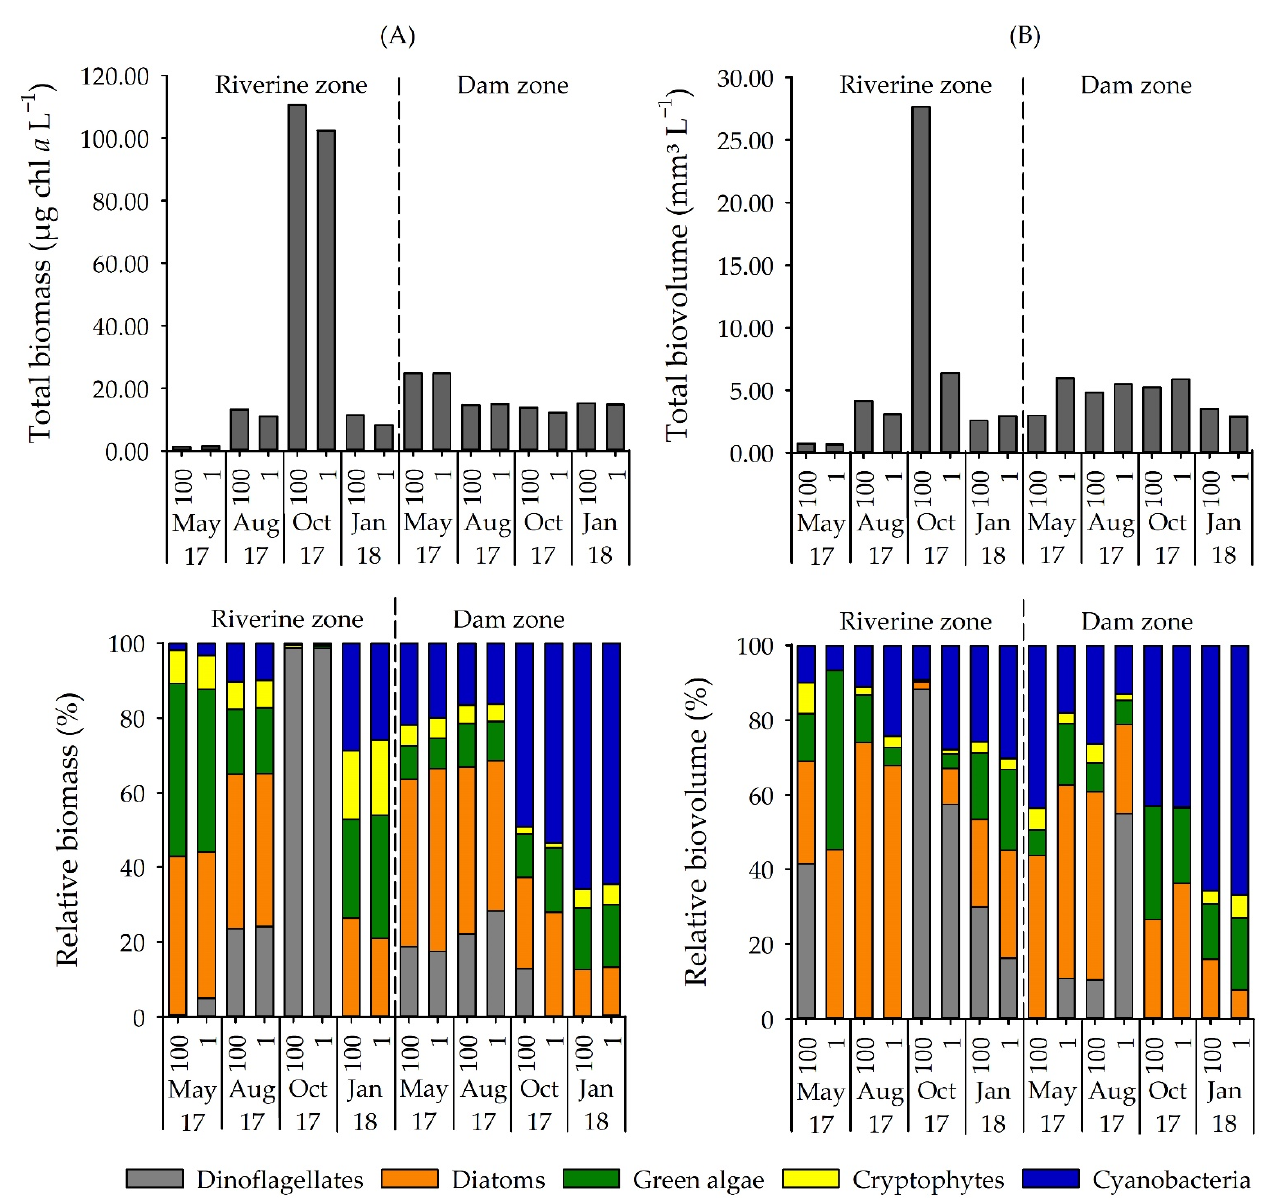
Figure 2. ( A ) Total biomass ( μ g chl a L − 1 ) and relative biomass (%) of phytoplankton groups determined by the pigment method and ( B ) total biovolume (mm 3 L − 1 ) and relative biovolume (%) of phytoplankton groups in Itupararanga reservoir. 100 = surface; 1 = lower limit of euphotic zone.